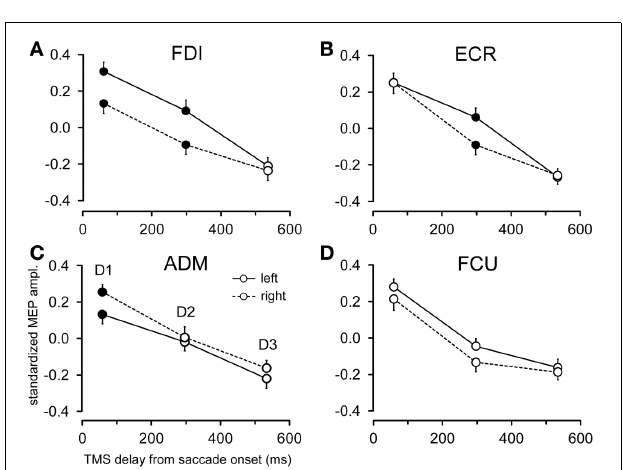
FIGURE 6 | Effects of target side on MEP amplitude. Mean MEP amplitudes across subjects are shown as a function of TMS delay for leftward and rightward saccades, irrespective of target eccentricity, in the FDI (A) , ECR (B) , ADM (C) , and FCU (D) muscles. Filled symbols denote a statistically significant difference between MEP amplitudes at a given TMS delay. Error bars represent the standard error of the